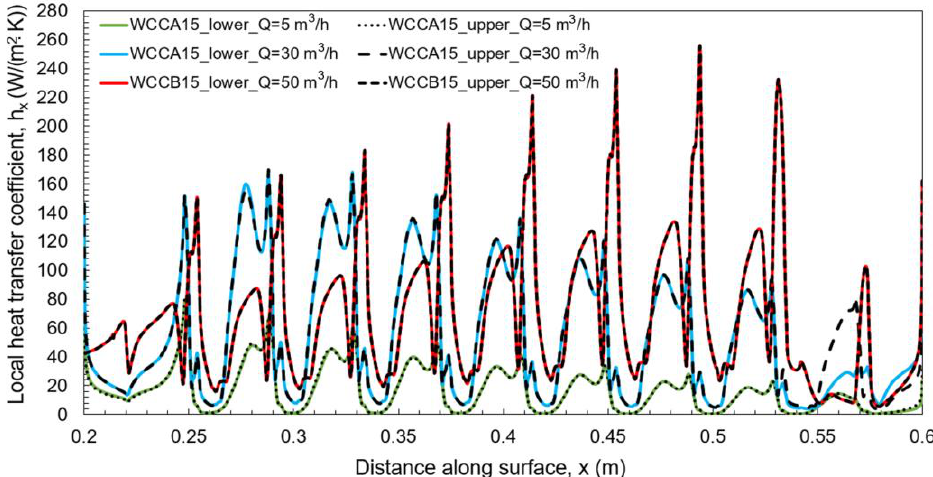
Figure 9. The comparison of the local heat transfer coefficients along lower and upper surfaces of the WCCA15 and WCCB15 configurations for CVGs position ‘1’ when changing the flow rate.